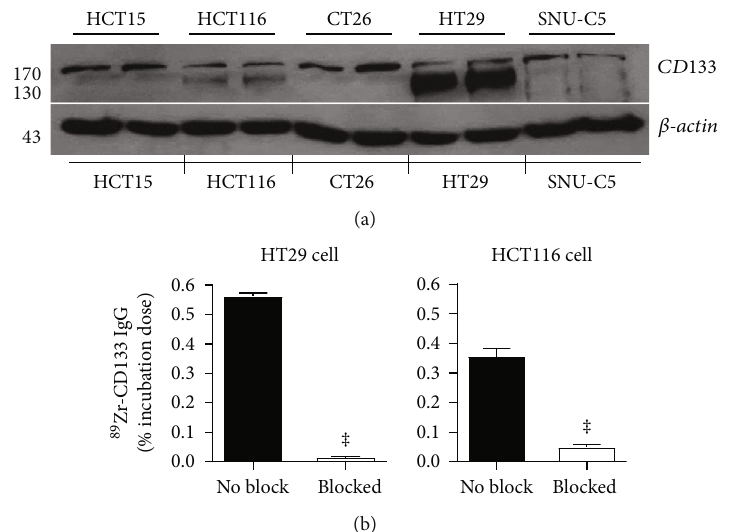
Figure 2: Colon cancer cell binding and pharmacokinetic properties of 89 Zr-CD133 IgG. (a) Western blotting of CD133 protein in various colon cancer cell lines (top) and 89 Zr-CD133 IgG binding to high-expressing HT29 and low-expressing HCT116 human colon cancer cells (bottom). (b) Speci fi city of binding was assessed by blocking with excess cold anti-CD133 IgG. Bars are means ± SD of % incubation dose obtained from a single representative experiment with triplicate samples. ‡ P < 0 : 001